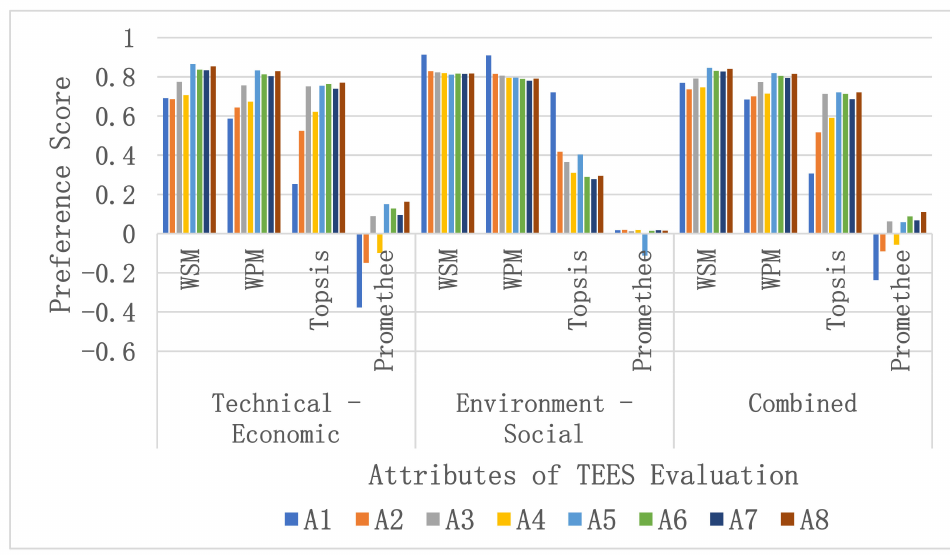
Figure 12. Attributes of TEES evaluation for C1/S5 with DGs only at OLG2 at 0.9